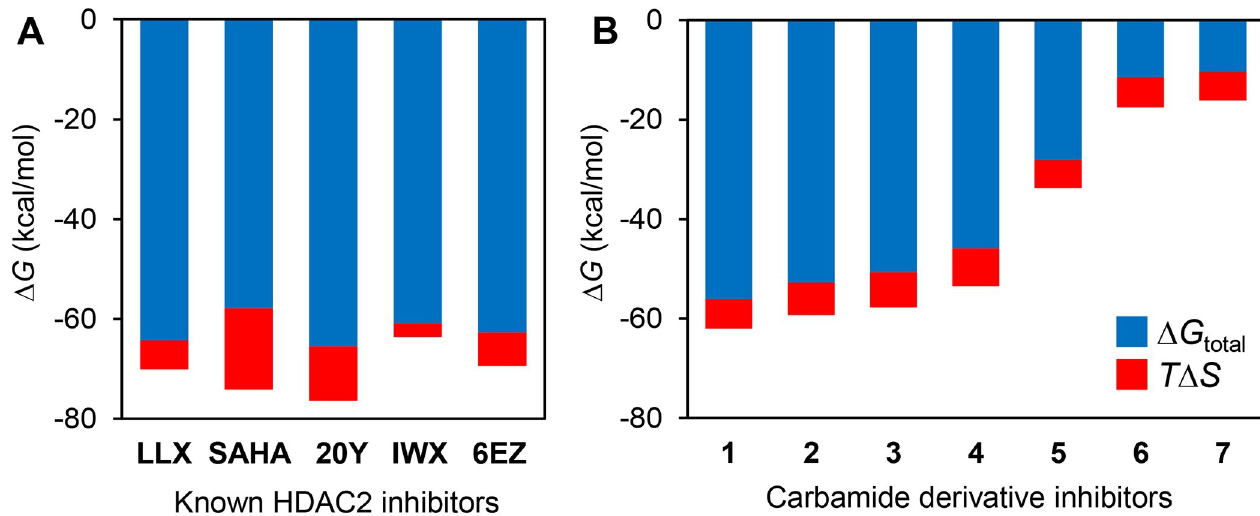
Fig 7. Binding free energies of either known inhibitors (A) or carbamide derivative inhibitors (B) comparing the scale of the entropic term contribution.